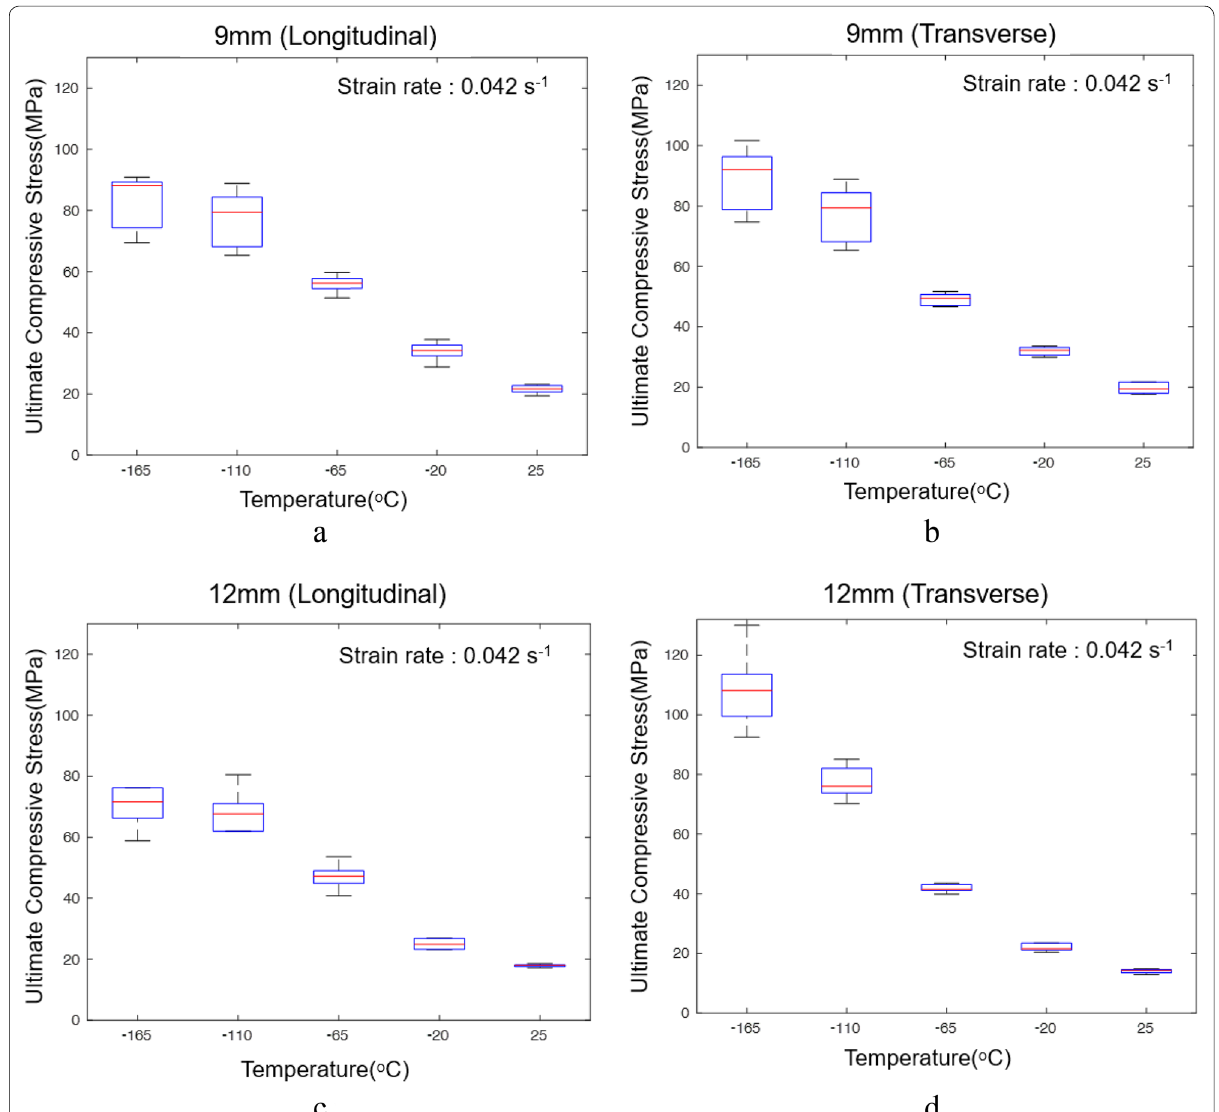
Fig. 8 a Average compressive strength and b average modulus of elasticity of plywood in longitudinal and transverse fiber